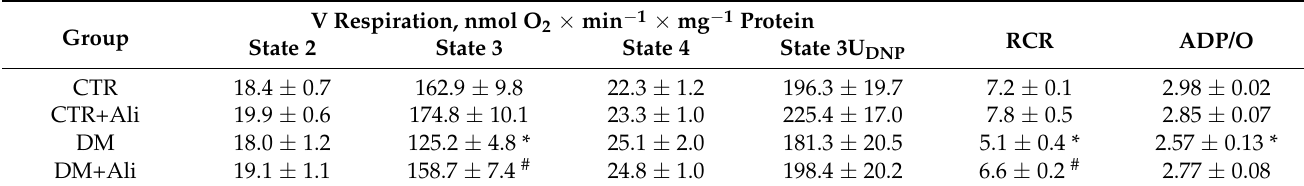
means ± SEM ( n = 6). * p < 0.05 compared to the control group (CTR). # p < 0.05 compared to the DM